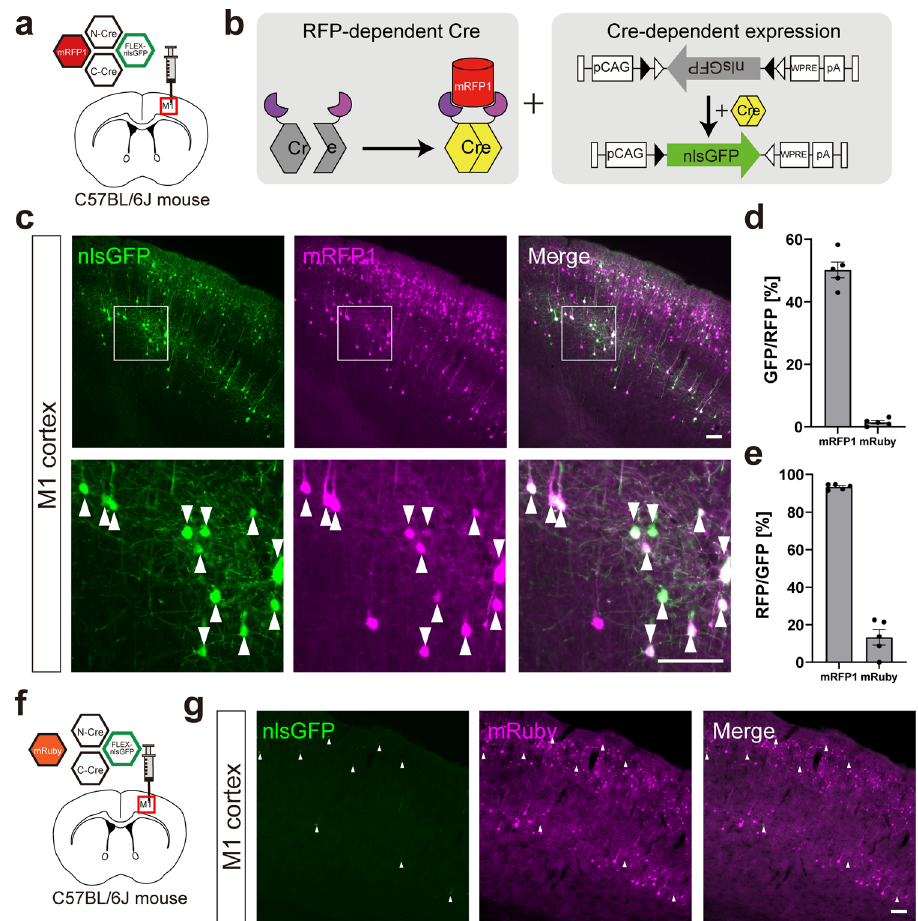
Fig. 4 Functional assay of Cre-DOR N6C1 in vivo. a Injection schema of the Cre-DOR N6C1 test with mRFP1 in wild-type mice. Four kinds of virus (NCre- MBP6, CCre-MBP1, FLEX-nlsGFP, and mRFP1) were injected in the M1 cortex at the same time. b Schematic representation of speci fi c expression of nlsGFP induced by Cre-DOR activated by mRFP1. c Fluorescent images of the M1 cortex. Scale bar = 100 μ m. d Quanti fi cation of cell counts to assess the ef fi ciency of Cre-DOR N6C1 ( n = 5 each). e Quanti fi cation of cell counts to assess the fi delity of Cre-DOR N6C1 ( n = 5 each). f Injection schema of the Cre-DOR N6C1 test with mRuby in wild-type mice. g Fluorescent images of the M1 cortex in which the four viruses were injected. Scale bar = 100 μ m. Data are means ±